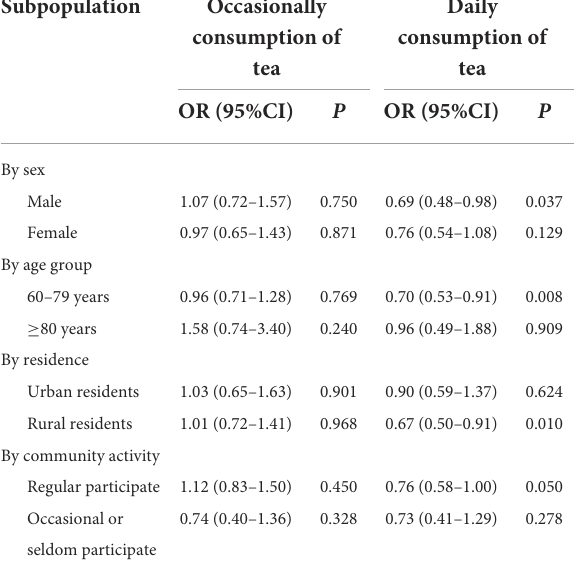
TABLE 3 Subgroup analyses of associations between tea consumption and